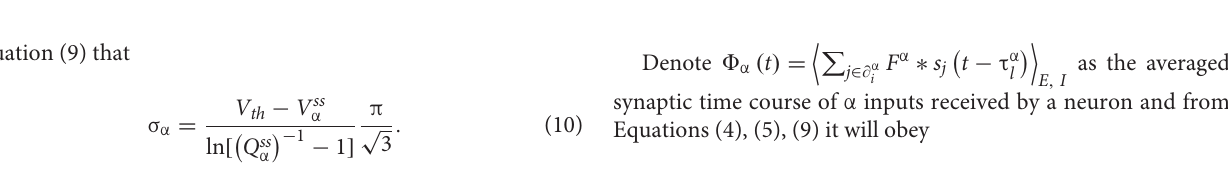
FIGURE 1 | Synchronization and network oscillation induced by slow inhibition in balanced networks. Fast inhibition (B,E,H) induces strict balance with asynchronous spiking and an almost steady network firing rate. Slow inhibition (C,F,I) results in loose balance, with synchronous grouped spiking and network oscillation. Individual neurons spike irregularly in both cases. (A) Normalized E/I post-synaptic response when receiving a pre-synaptic spike. (B,C) Raster plot of the spiking time. Each blue/red point corresponds to a spike of the E/I neuron. (D) The distribution of membrane potential. (E,F) The corresponding firing rate of E population (blue) and the firing rate predicted by the field equations (green). (G) The pdf. of the CV of ISI of E neurons. (H,I) The blue/red curves represent the average input E/I current of a neuron in the network and the black curves represent the difference between them. The parameters are set as Q o = 5 Hz ; τ I d = 1 ms in the fast inhibition case ( B,E,H and left panels of D,G ) and τ I d = 3 . 5 ms in the slow inhibition case ( C,F,I and right panels of D,G